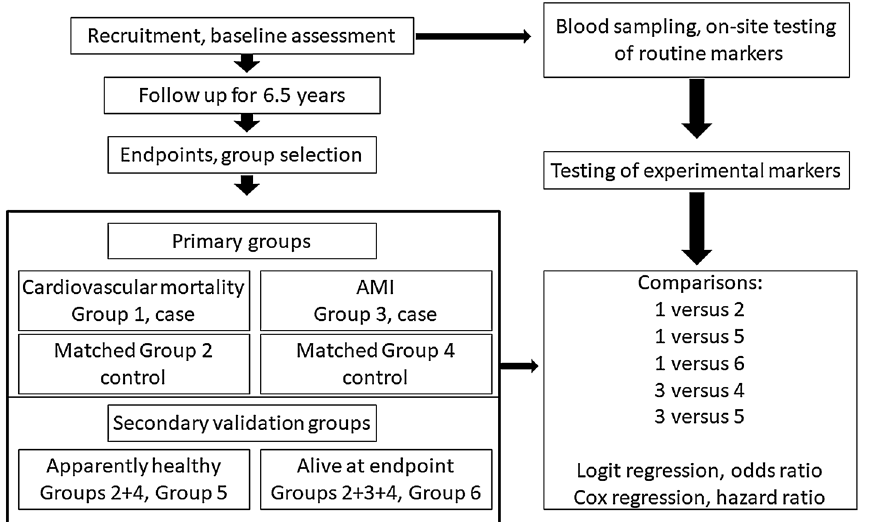
Figure 1. The workflow of analysis. Notable, group 2 was selected as individual matches to group 1, and group 4 was selected as individual matches to group 3 according to the criteria described in the text in